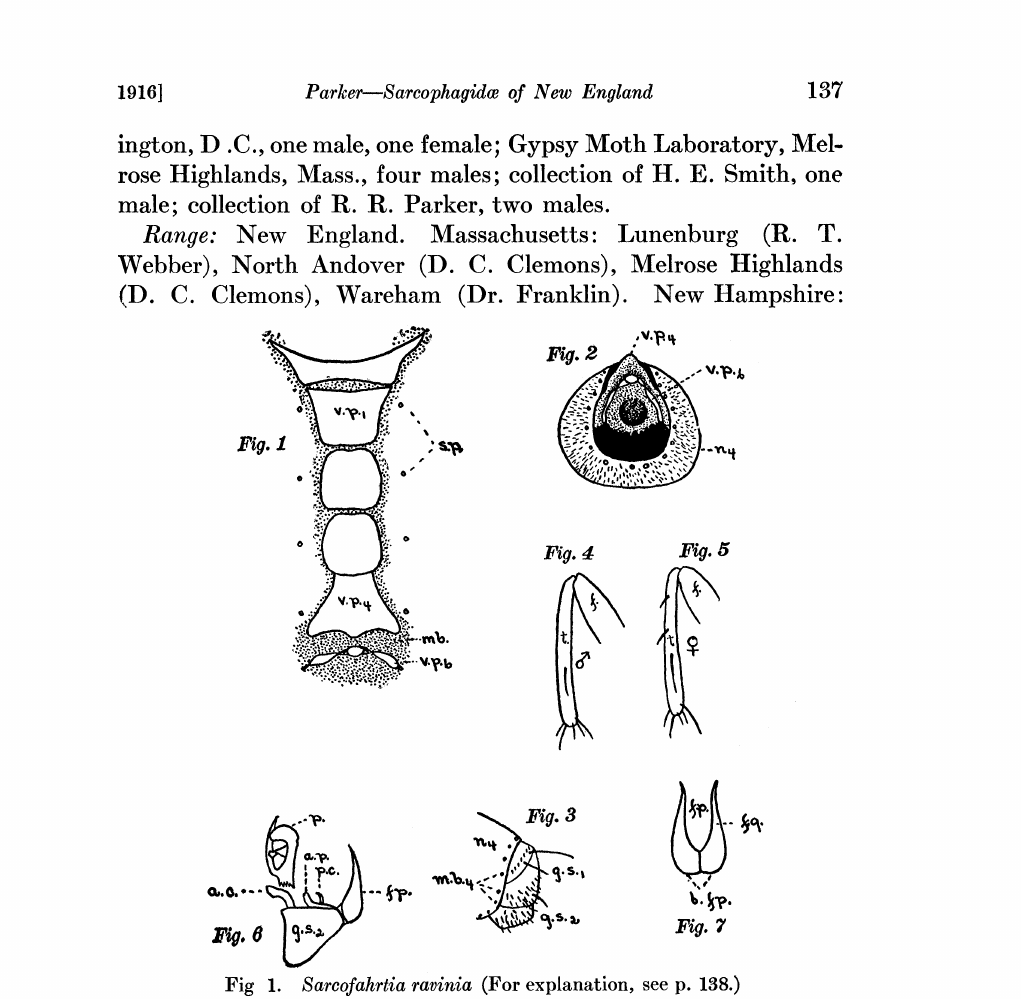
Fig 1. Sarcofahrtia ravinia (For explanation, see p. 138.) Franconia (Mrs. Slosson). Connecticut: Hamden (B. H. WaldenJ. Inclusive dates of capture, May 0 and August